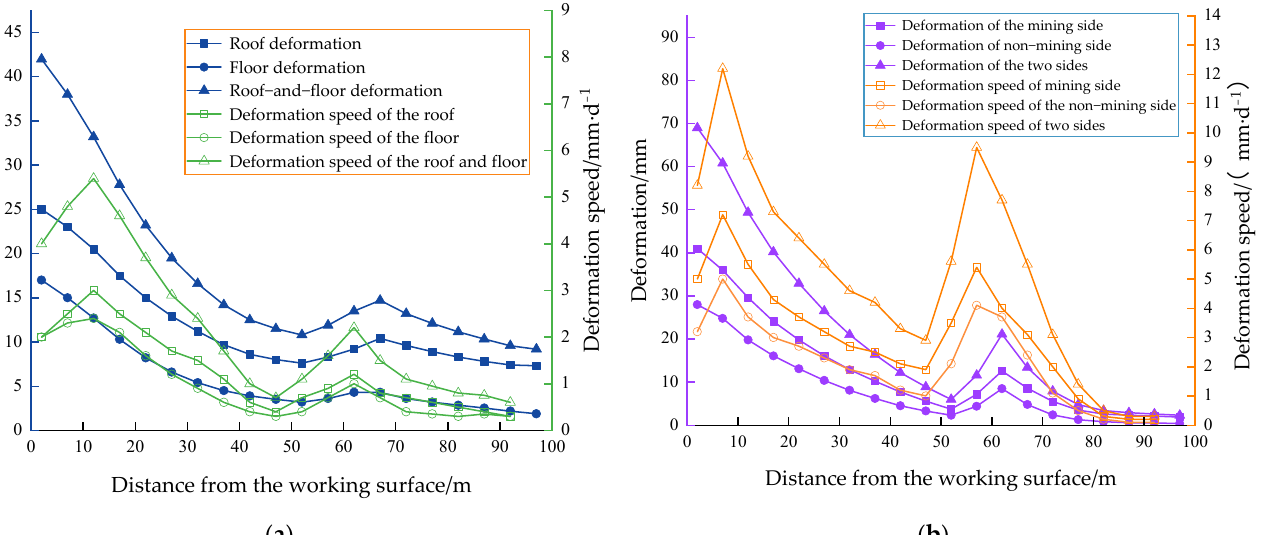
Figure 15. Monitoring of deformation and speed of roadway surrounding rock. ( a ) Deformation of the roof and floor of the roadway; ( b ) Deformation of the coal sides of the roadway.